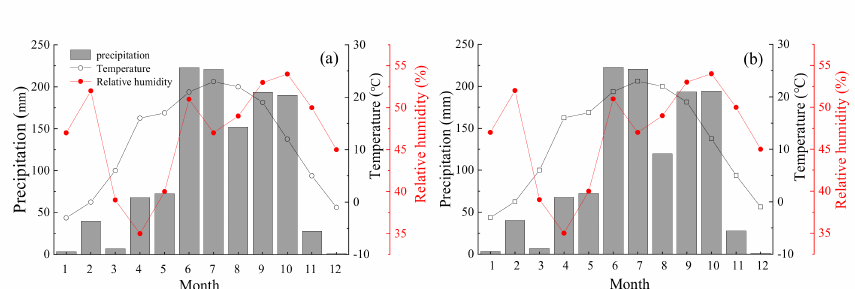
Figure 2. Variations in temperature, precipitation and relative humidity at the hillside ( a ) and floodplain ( b ) habitats during the sampling periods. The meteorological data were downloaded the weather query website (https: // tianqi.911cha.com / ).